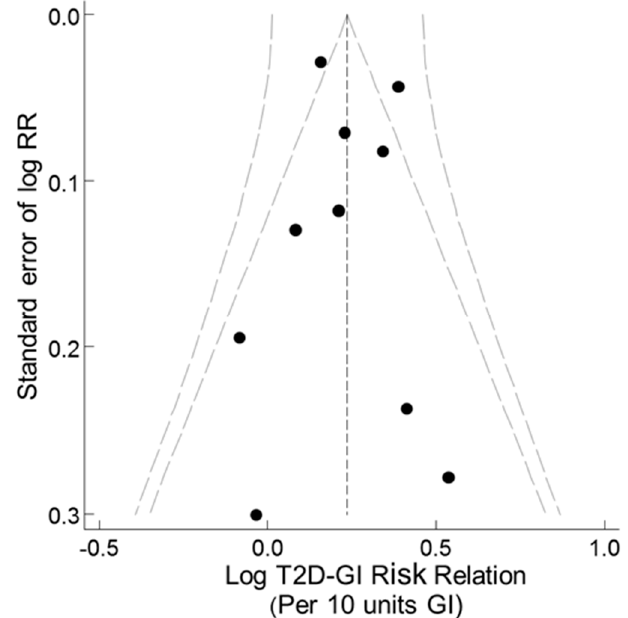
Figure 4. Funnel plot of the study results for the T2D–GI risk relation for valid studies using valid dietary instruments. Valid studies were those with valid dietary instruments (correlation coe ffi cient for carbohydrate or carbohydrate foods > 0.55, deemed a prior) and not including an outlier study [38]) (Table S15) ( p < 0.05, deemed a priori in the random e ff ects model. The inverted funnel shows the study-level 95% confidence limits with fixed e ff ects, the outer funnel shows the study-level 95% confidence limits with random e ff ects, and the vertical dashed line shows the combined studies random e ff ects trim-and-fill mean, which exponentiated was 1.27 (1.15–1.40) ( p < 0.001, n = 10 studies).